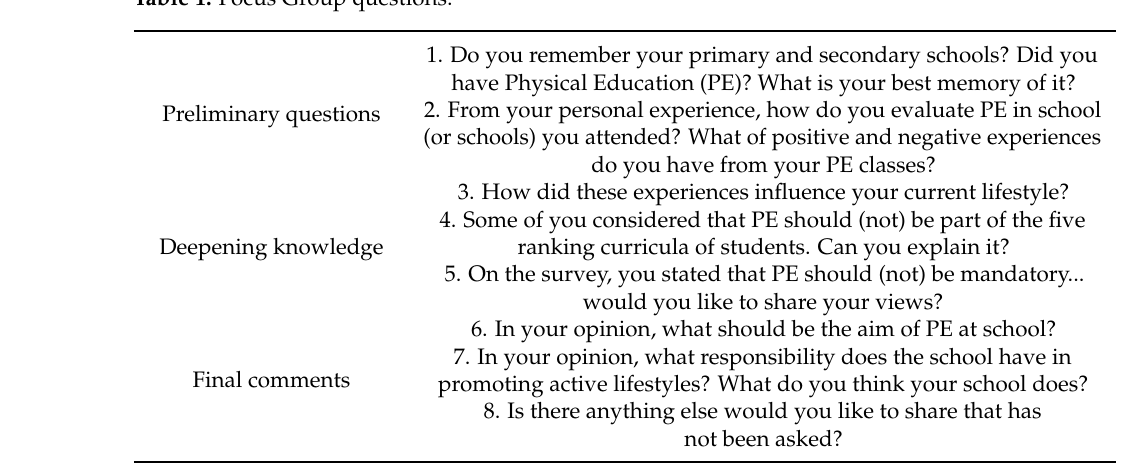
Table 1. Focus Group